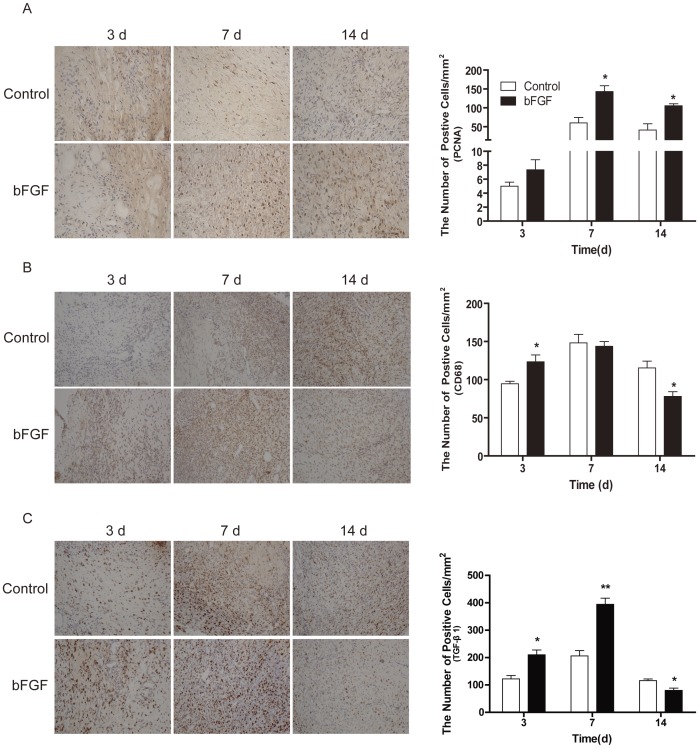
The expression of PCNA, CD68 and TGF-β1 after bFGF treatment.Immunohistochemistry of (A) PCNA, (B) CD68 and (C) TGF-β1 was performed on the indicated day (×200); the histogram represents the positive cells and optical density of the immunohistochemistry results. *P<0.05 and **P<0.01 compared to control group, n = 8.